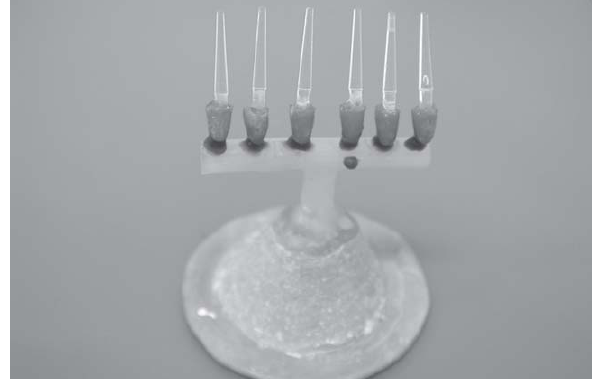
FIGURE 4- G2- 6 patterns/medium ring